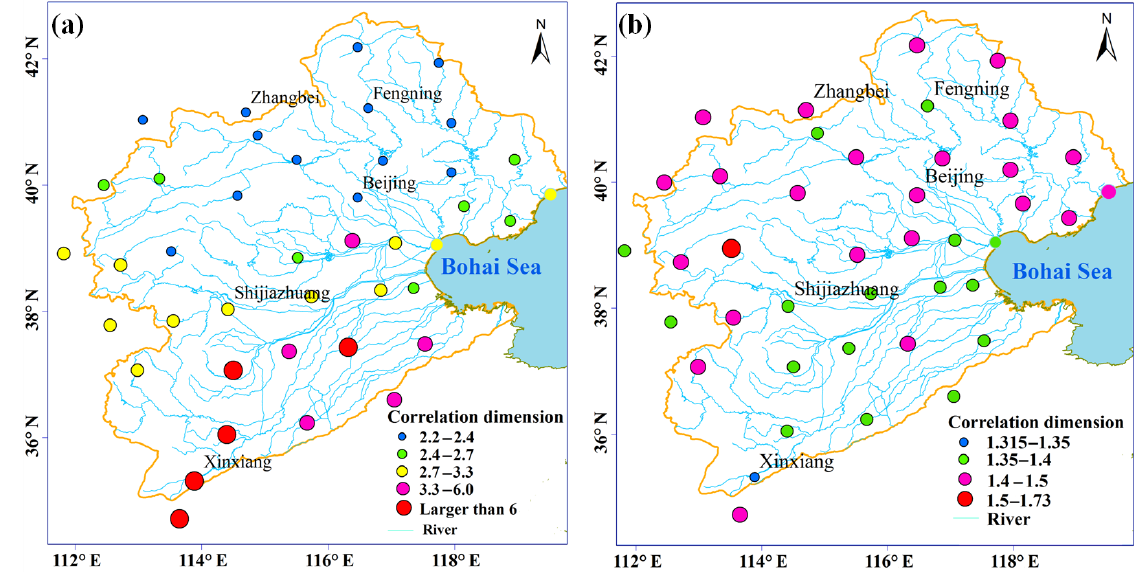
Figure 8. The spatial distribution of the correlation dimension values for all the 40 stations: (a) precipitation and (b)